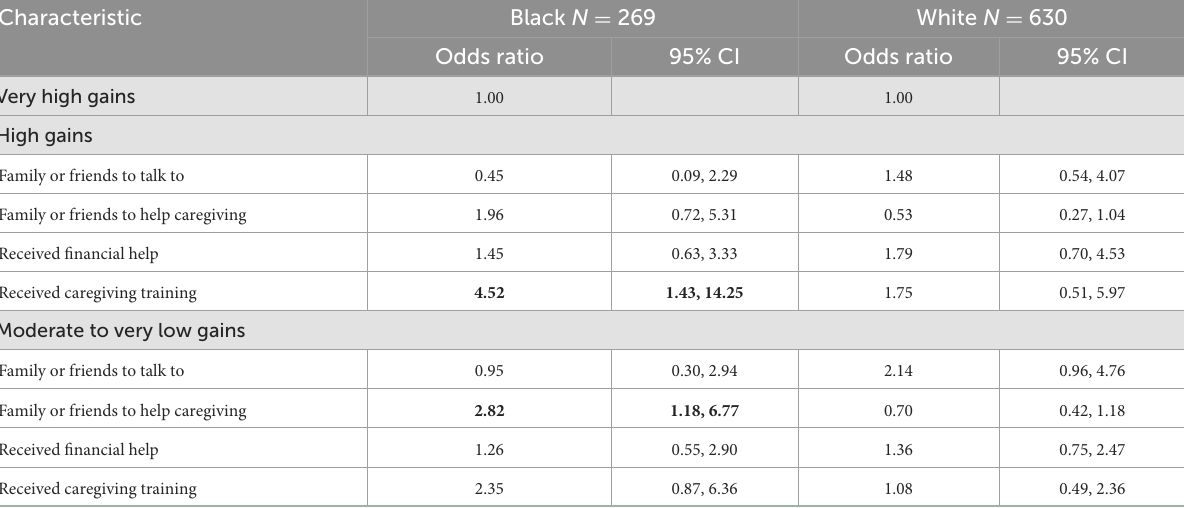
TABLE 3 Caregiver gains and